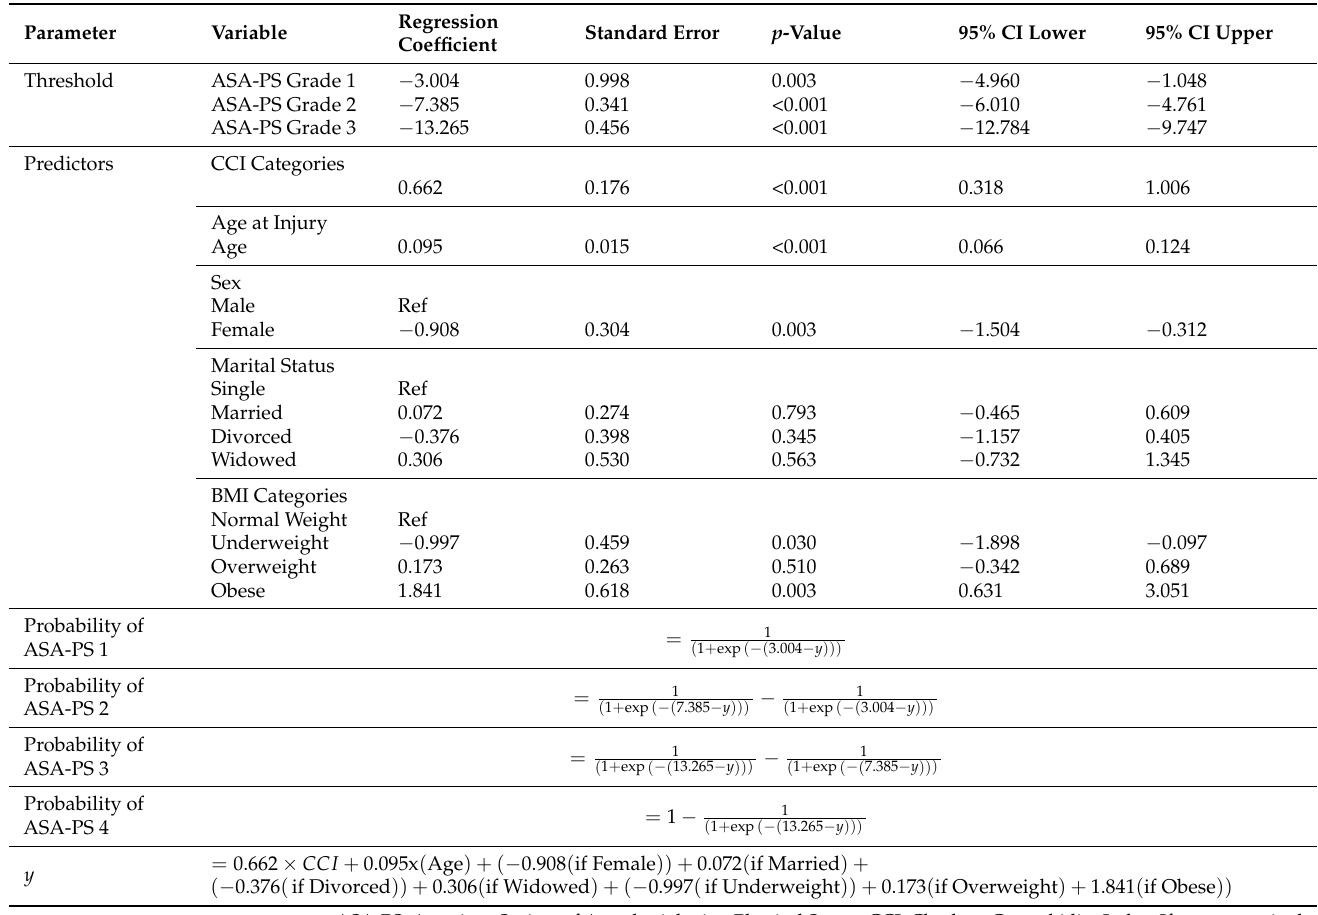
Table 5. Threshold and equations for computing predicted ASA-PS categories using multivariate ordinal logistic regression model on the full